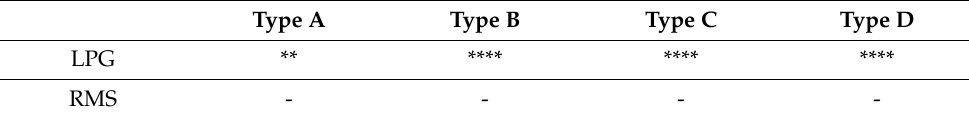
Table 7. TukeyHSD test results for the VRU location